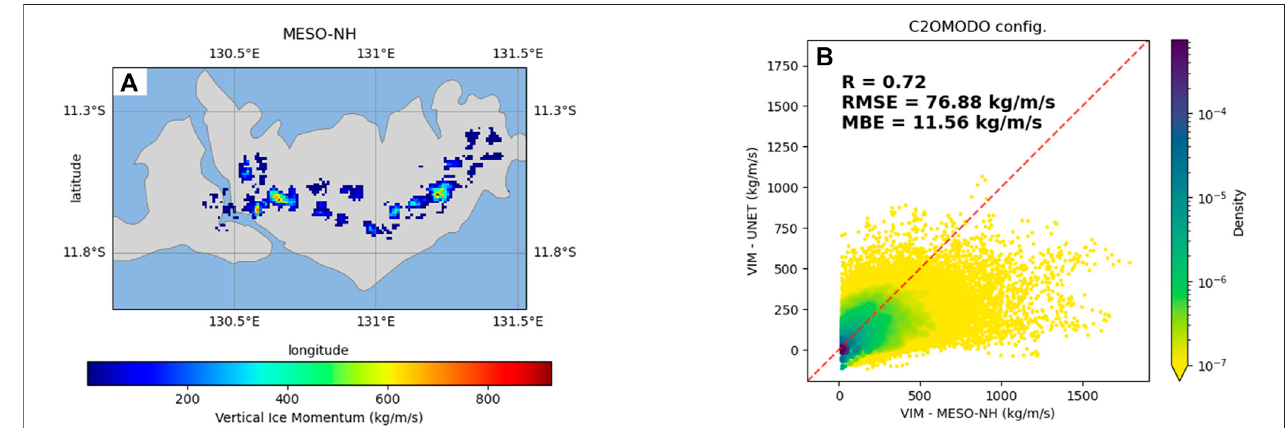
FIGURE11|(A) Verticallyintegratedicemass fl ux(VIM,kg/m/s)assimulatedbyMESO-NHforasnapshotoftheHECsetofsimulations. (B) Meso-NHVIM( x -axis) versuspredictedVIM( y -axis)forthe fi ltereddeepconvectivesituationswithintheentirevalidationdataset.ThePearsoncorrelationcoef fi cient(R),root-mean-squareerror (RMSE) and mean bias (MBE) are indicated. The color scale for the scatter plot represents the normalized density of data, in log scale.